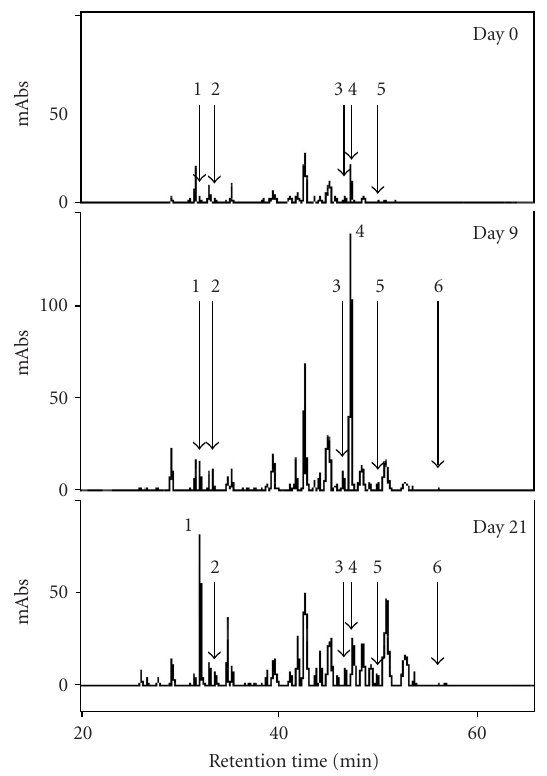
Figure 1. HPLC chromatogram of phenolic compounds moni- tored in crude extract of the PL cell line suspension culture over one growth period of 24 days in a high-anthocyanin production medium. 1: ca ff eic acid (CA); 2: chlorogenic acid (CH); 3: 3,4- dica ff eoylquinic acid (3,4-DCQA); 4: 3,5-dica ff eoylquinic acid (3,5-DCQA); 5: 4,5-dica ff eoylquinic acid (4,5-DCQA); 6: 3,4,5- trica ff eoylquinic acid